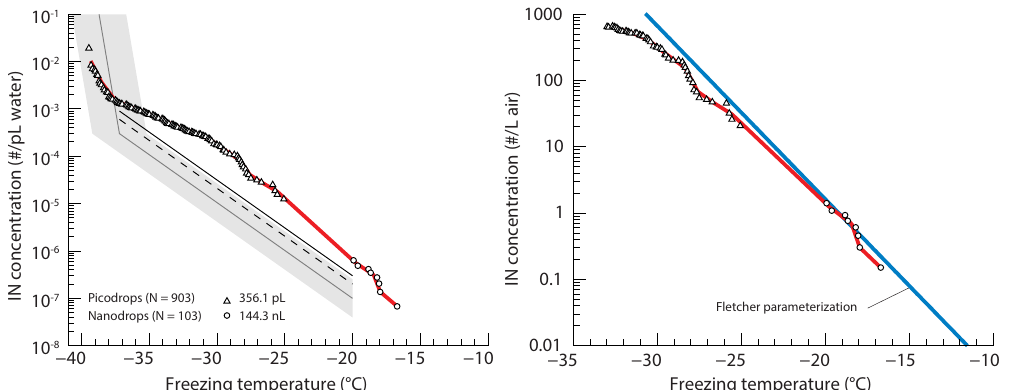
Figure 5. Example cumulative ice nuclei spectra from the SAC on 8 April. Left: analysed in the same manner as shown in Fig. 4. The grey shaded area corresponds to the background concentration in the water samples shown in Fig. 3. Due to the addition of pure water to the SAC to maintain operation, the noise level was either multiplied by 2 (dashed line) or 3 (thick solid line) depending on the SAC run time. Right: same data as in the left plot but with background concentration (thick solid line in this case) of IN in the ultrapure water subtracted and expressed as IN L − 1 of air. The red line is the 1 ◦ average of the IN concentration. Overlaid in blue is the Fletcher parameterization using Eq. (7).